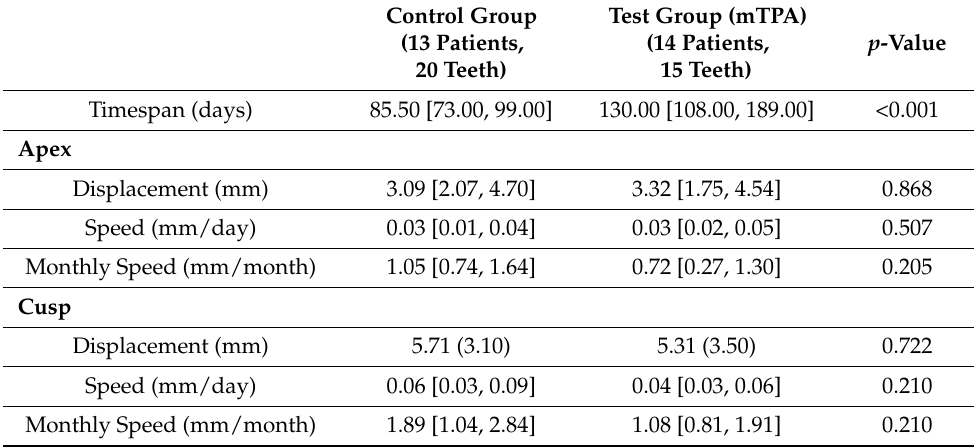
Table 1. Median or mean of displacements in each group; p -value: Mann–Whitney U test or Student’s t -test. mTPA: miniscrew with transpalatal